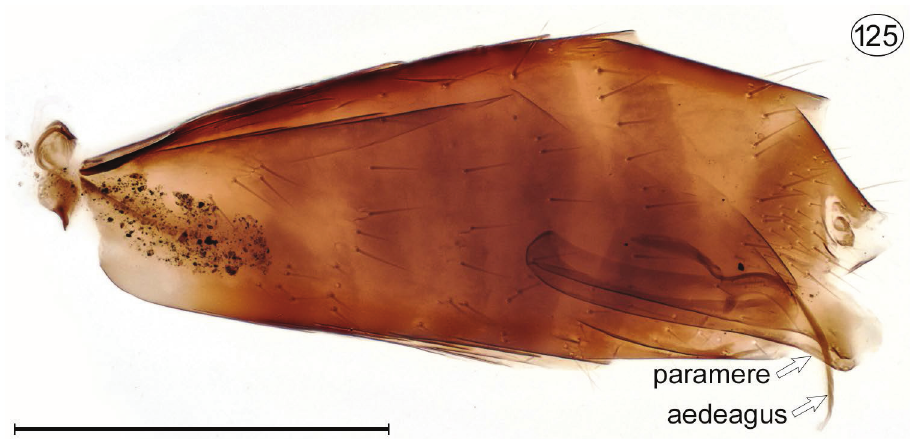
Figure 125. Neotriadomerus longiovipositor , male paratype (near historical mine site, NW of Chillagoe). Gaster, median plane showing genitalia. Scale bar = 300